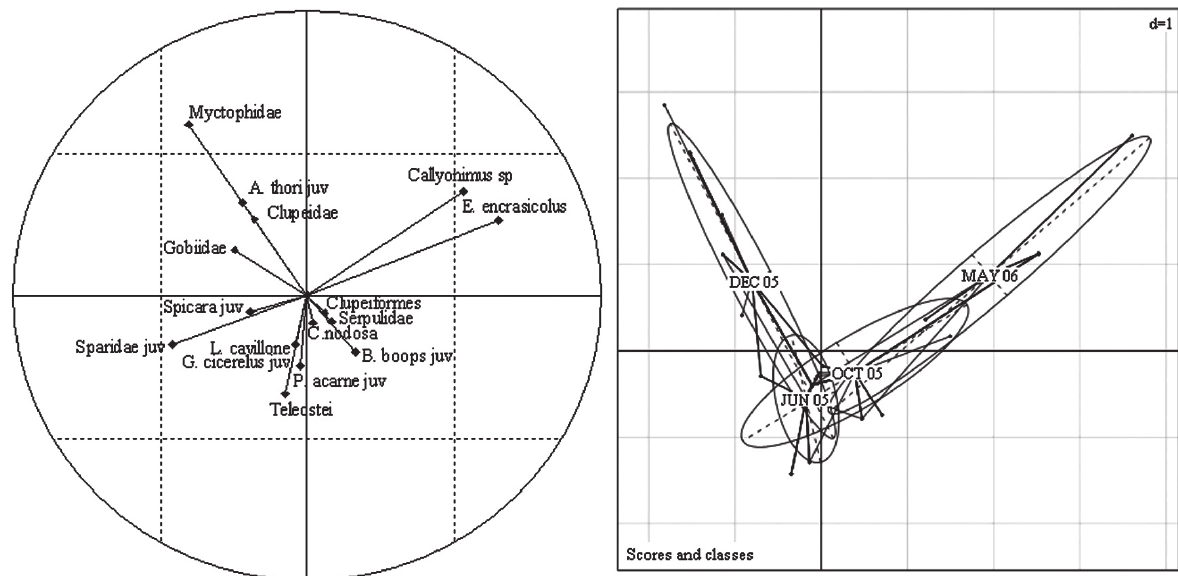
Fig . 4 – correspondence discriminant analysis (cda) computed for study periods explaining 83.8% of the total